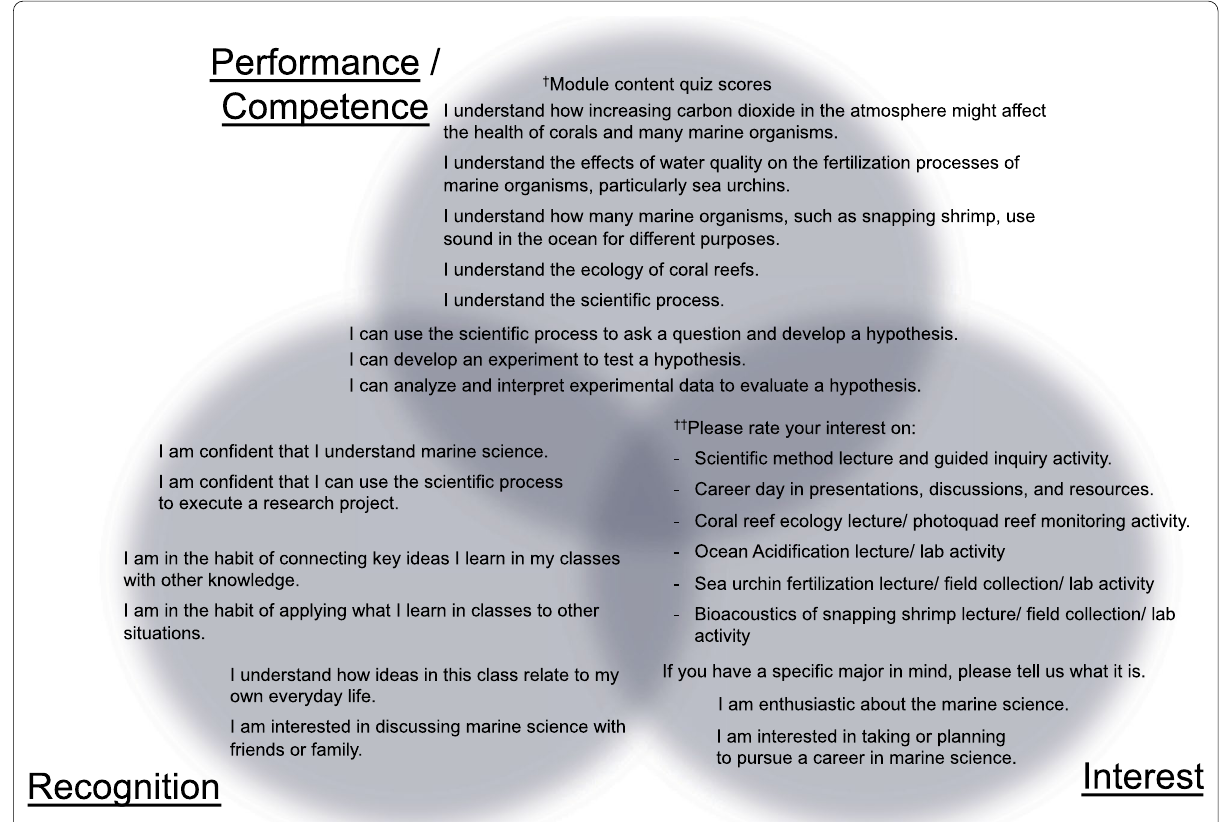
Fig. 4 Instrument Items within Identity Framework. Note. Categorization of iClicker module quizzes and Research Experiences in Marine Science (REMS) Program survey items aligned with the science identity model constructs they reflect. The overlapping background circles in the image reflect the overlapping nature of the identity constructs. The survey items are ordered and indented to fit within the construct circles and